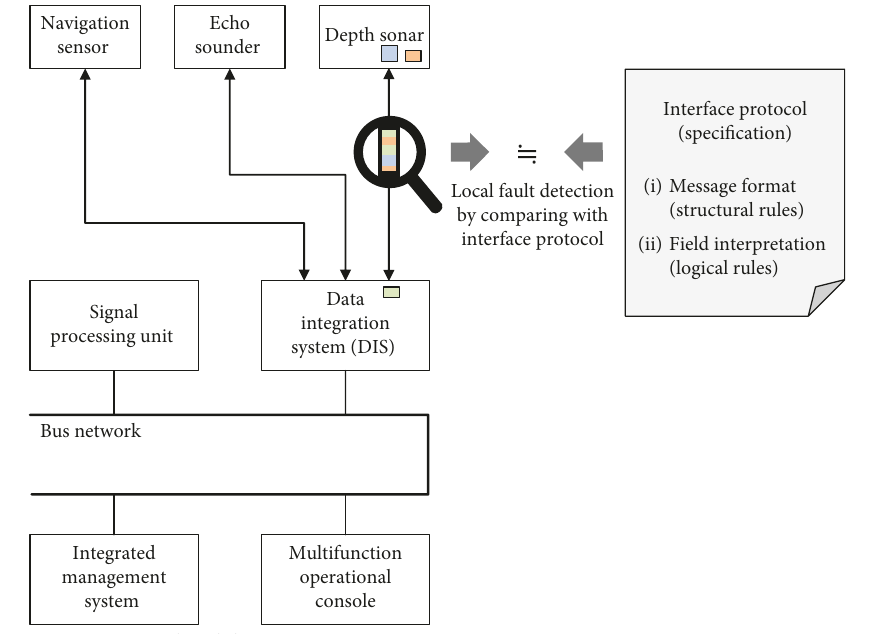
Figure 1: Local faults in SoS-based ship